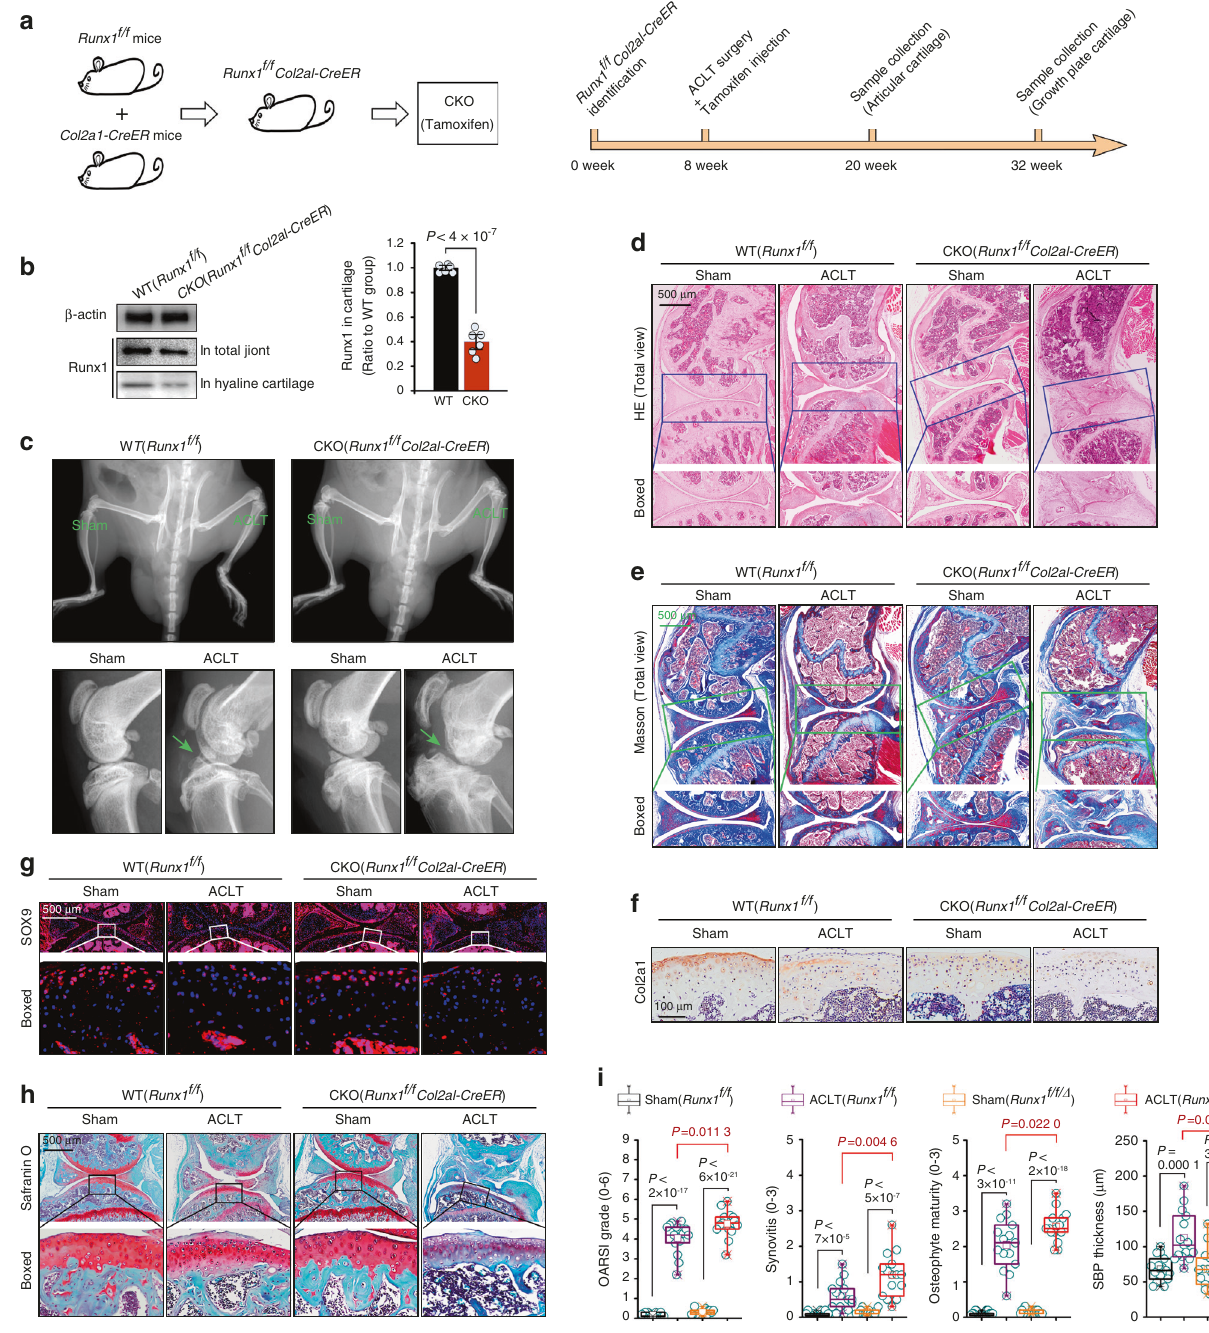
Fig. 1 Runx1 knockout aggravates articular cartilage destruction in an ACLT-induced mouse OA model. a Schematic diagram showing the generation of Runx1-knockout mice and the detailed sample collection procedure. We achieved chondrocyte-speci fi c Runx1 knockout by intraperitoneal tamoxifen injection at 3 – 5 days after recovery from ACLT surgery. We performed intraperitoneal tamoxifen injection twice per week. After 2 weeks of injections, cartilage genotyping was performed to determined whether Runx1 knockout was achieved. b Western blotting and quanti fi cation showing the expression of Runx1 in the total joint and articular cartilage of Runx1-knockout mice. c In vivo imaging showing the joint destruction in Runx1-knockout mice at 12 weeks after ACLT surgery. d H&E staining showing pathological changes in articular cartilage in Runx1-knockout mice at 12 weeks after ACLT surgery. e Masson staining showing pathological changes in articular cartilage in Runx1-knockout mice at 12 weeks after ACLT surgery. f IHC staining showing the expression of Col2a1 in articular cartilage in Runx1-knockout mice at 12 weeks after ACLT surgery. g Immuno fl uorescence showing the expression of SOX9 in articular cartilage in Runx1-knockout mice at 12 weeks after ACLT surgery. h Safranin O staining showing the loss of proteoglycan in articular cartilage in Runx1-knockout mice at 12 weeks after ACLT surgery. i The degree of experimental mouse OA was evaluated by scoring cartilage destruction (Osteoarthritis Research Society International (OARSI) grade), synovitis, osteophyte maturity, and subchondral bone plate (SBP) thickness (suggestive of sclerosis). Runx1 f/f/ Δ Runx1 knockout. These results are based on at least three independent experiments ( n = 3). The standard Mann – Whitney U test was used for the OARSI grade, synovitis, osteophyte maturity and SBP thickness, and the data in i (right) are shown as box (from 25%, 50% to 75%) and whisker (minimum to maximum values) plots. All signi fi cance data presented in b and i are based on two-tailed Student ’ s t